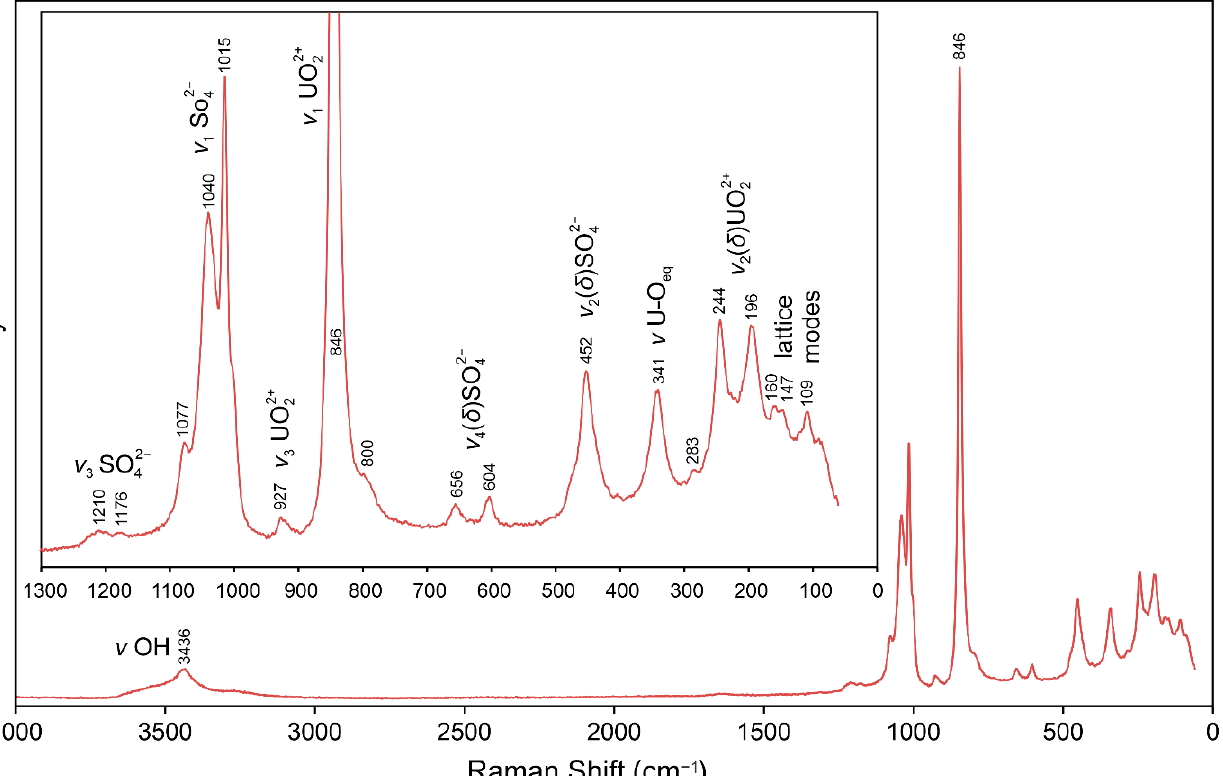
perceptible band at about 1630–1650 cm − 1 is presumably related to the ν 2 ( δ ) bending vibrations of H 2